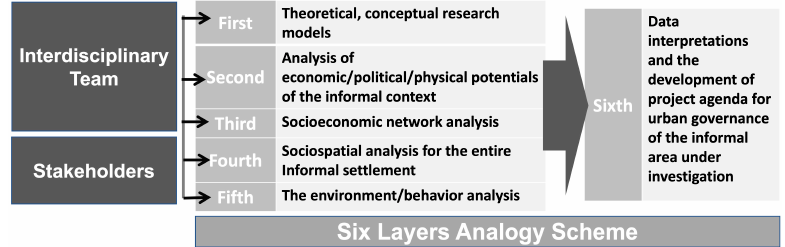
Figure 6. The Six ‐ layer Analogy Scheme. Figure 6. The Six-layer Analogy